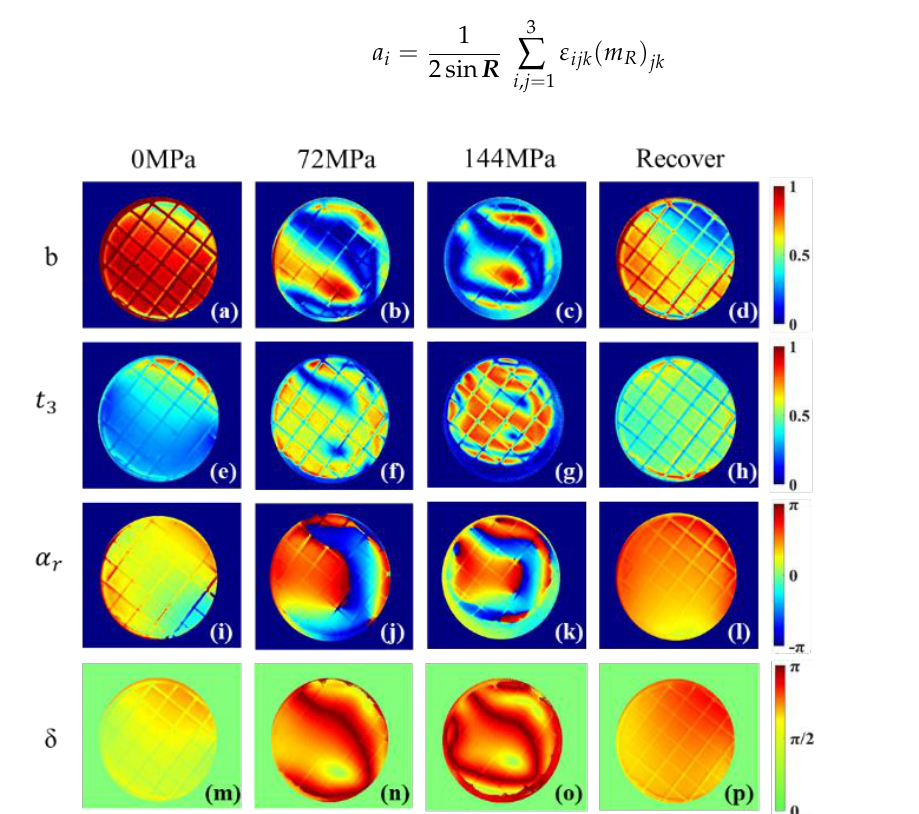
Figure 4. b , 𝑡 3 , 𝛼 𝑟 , 𝛿 images of sample after 0 MPa, 72 MPa and 144 MPa pressure and those after 24 Figure 4. b , t 3 , α r , δ images of sample after 0 MPa, 72 MPa and 144 MPa pressure and those after 24 h h recovery. ( a – d ): b images; ( e – h ): 𝑡 3 images; ( i – l ): 𝛼 𝑟 images; ( m – p ): 𝛿 images. recovery. ( a – d ): b images; ( e – h ): t 3 images; ( i – l ): α r images; ( m – p ): δ